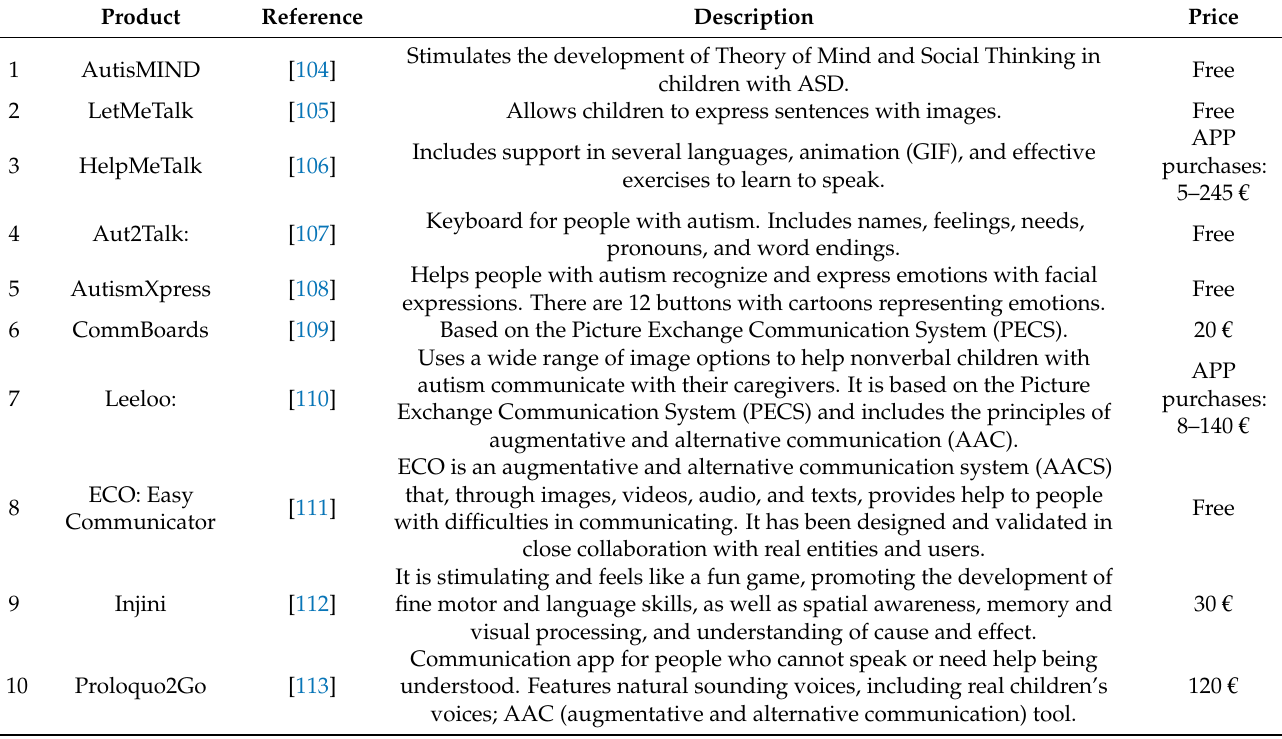
Table 15. Sample of commercial products in the form of virtual environments.